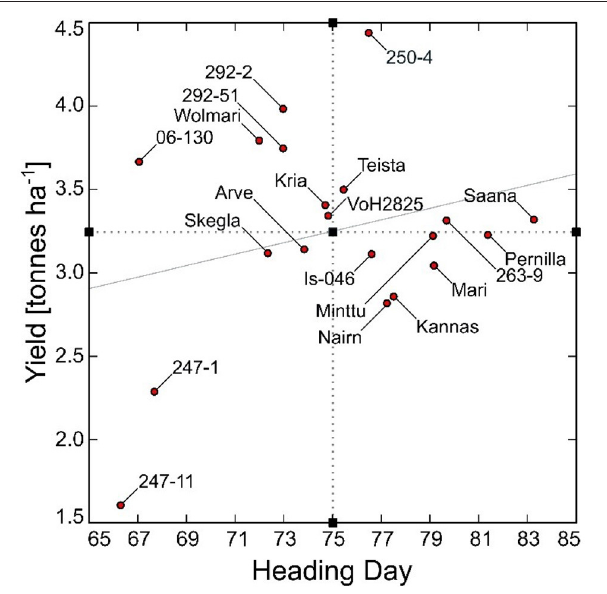
FIGURE 1 | Yield (t ha − 1 ) and heading day (days from sowing to heading) for 20 barley genotypes under Icelandic environmental conditions for the period 1987–2014. The mean values for heading day and yield are indicated as black boxes on the x- and y-axes, respectively, and the trendline is indicated as the gray